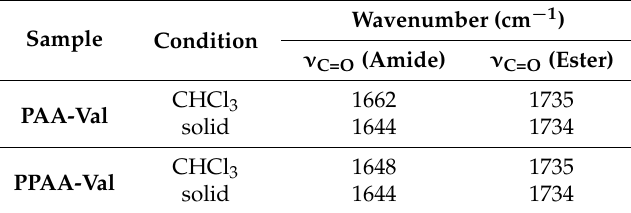
Table 2. ν C=O of PAA-Val and PPAA-Val measured in CHCl 3 and solid state a .